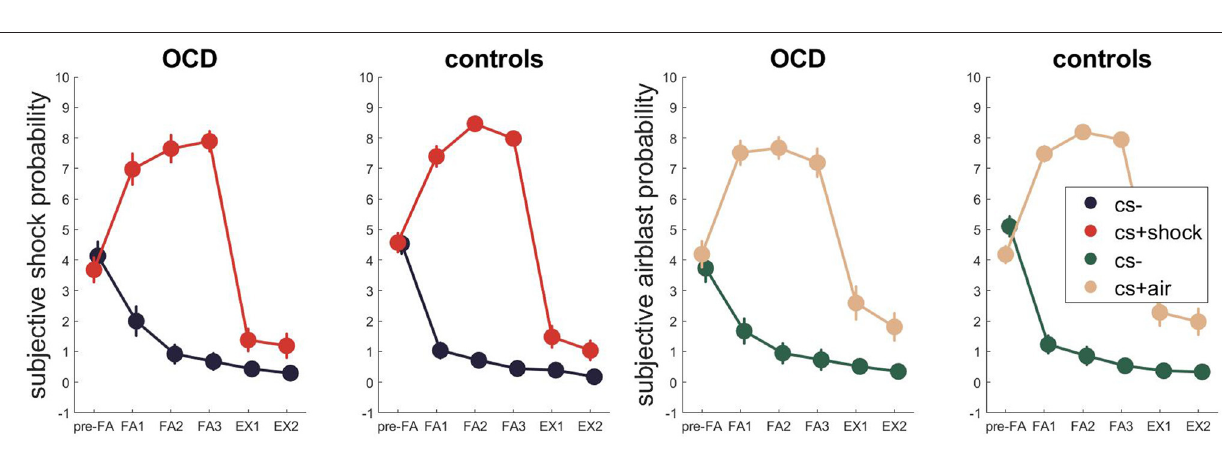
FIGURE 5 | Subjective US expectancy across fear acquisition and extinction. Error bars are standard errors of the mean.